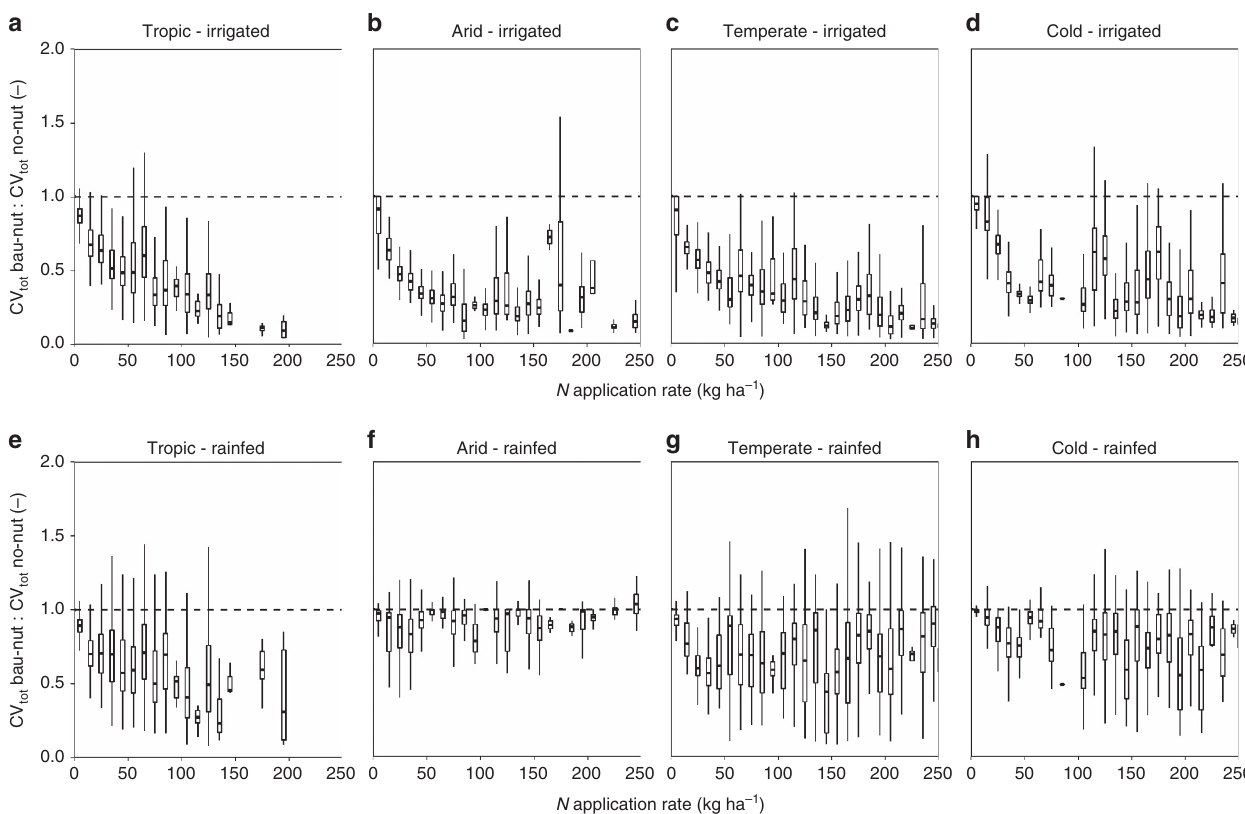
Figure 3 | Boxplots showing the ratio of the coefficient of variation in the whole soil set for the business as usual compared with the no nutrient input scenario. Ratios of the coefficient of variation for the whole soil set (CV tot ) for the business as usual (bau-nut) to no nutrient input (no-nut) scenarios are depicted for various Koeppen–Geiger climate regions and water management scenarios: ( a ) tropic and sufficient irrigation water supply, ( b ) arid and sufficient irrigation water supply, ( c ) temperate and sufficient irrigation water supply, ( d ) cold and sufficient irrigation water supply, ( e ) tropic and rainfed water supply, ( f ) arid and rainfed water supply, ( g ) temperate and rainfed water supply and ( h ) cold and rainfed water supply. The dashed line at intersect y ¼ 1 serves as a reference for CV tot values in the no-nut scenario. Fertilizer application rates were binned in steps of 10kgNha (cid:2) 1 . The extent of the x axis was limited to a maximum of 250kgNha (cid:2) 1 for better readability. Details on the fertilizer application rates are provided in the Methods section (Table 3) and Supplementary Fig. 3. Supplementary Fig. 1 shows the major Koeppen–Geiger climate regions as defined in Supplementary Table 1 52 . CV tot , the coefficient of variation for the whole soil